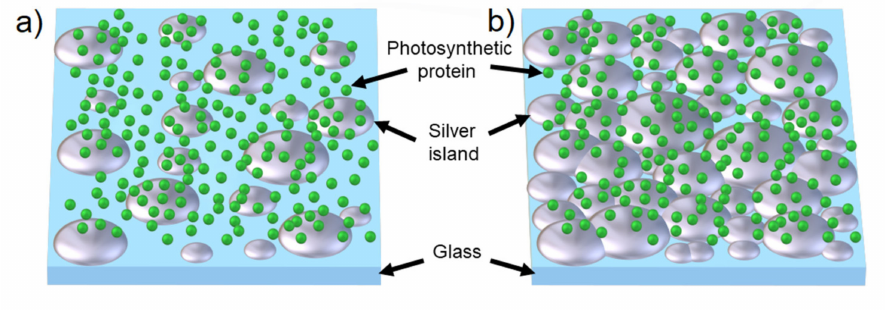
Figure 8. Schematic concept of the di ff erence between semi-transparent ( a ) and dense ( b ) SIF layers in biohybrid nanostructure. The concentration of photosynthetic complexes is the same for both